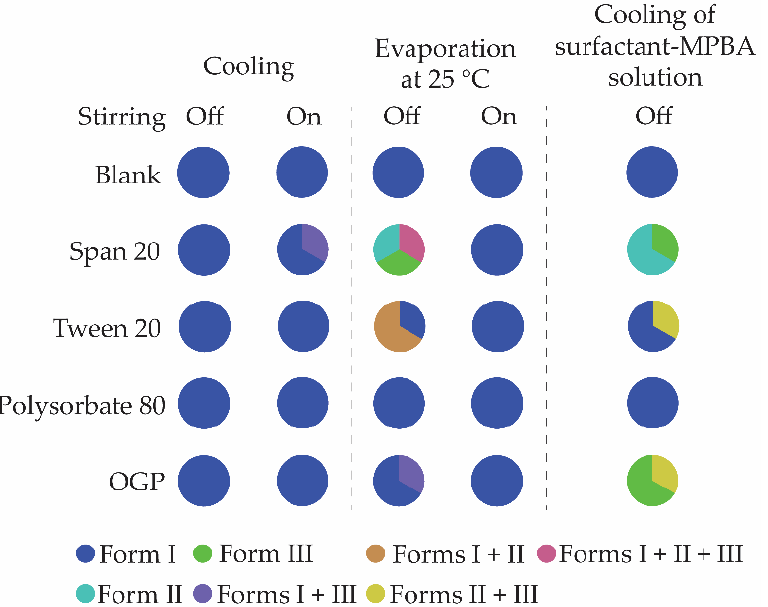
Figure 5. Polymorphic outcome in crystallization from toluene in the presence of surfactants using different crystallization methods. Each third of the circle represents one of the parallel experiments.